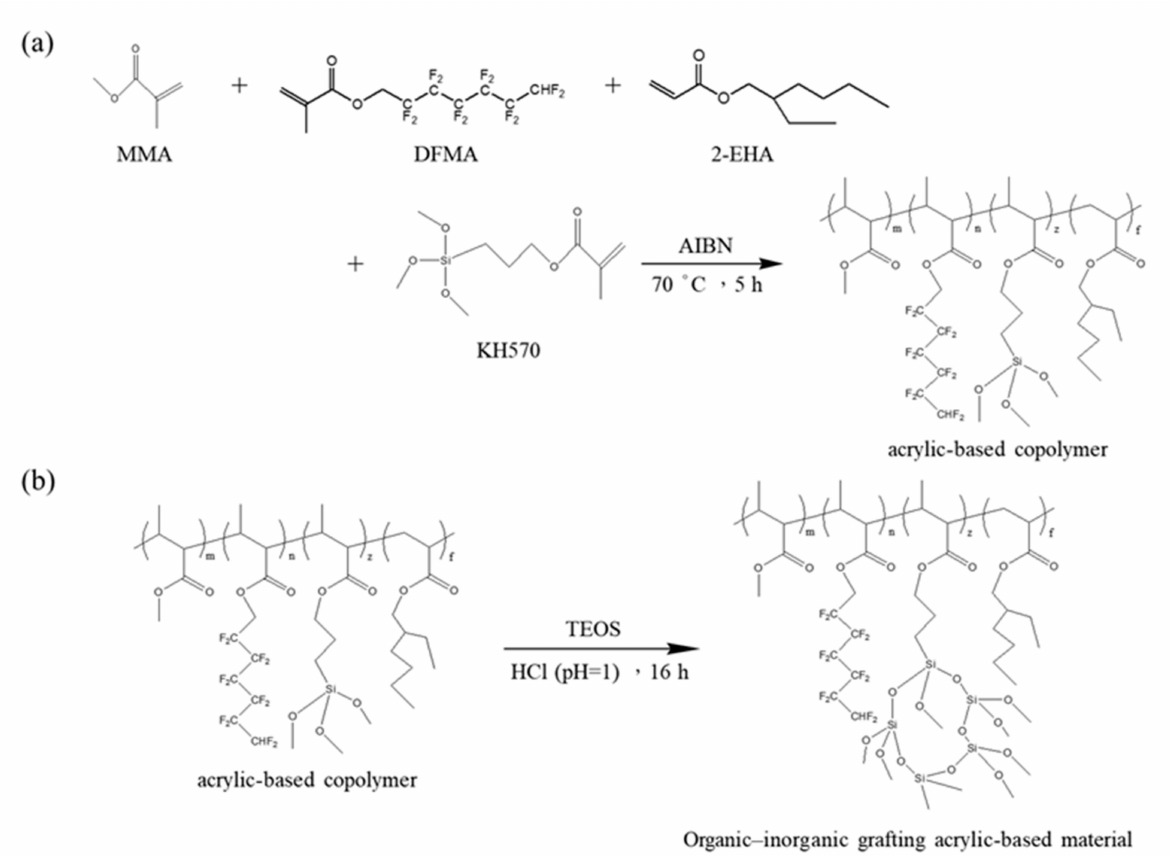
Figure 1. Copolymerization reactions of the organic-inorganic nanohybrid silica polyacrylate materials: ( a ) the schematic of the preparation of acrylic-based copolymer, ( b ) the schematic of organic-inorganic grafting acrylate-SiO 2